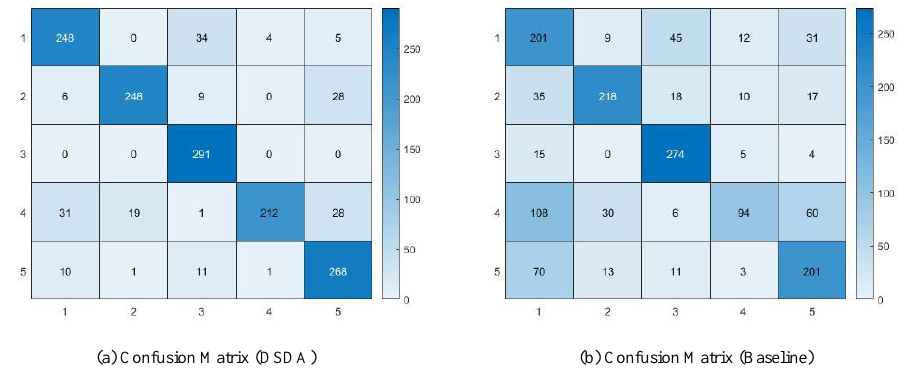
Figure 6. ( a ) Confusion matrix (5 × 5) of human identification from DSDA and ( b ) Confusion matrix (5 × 5) of human identification from baseline [10] on IDRad validation split. Vertical axis denotes ground-truth type and horizontal axis denotes predicted